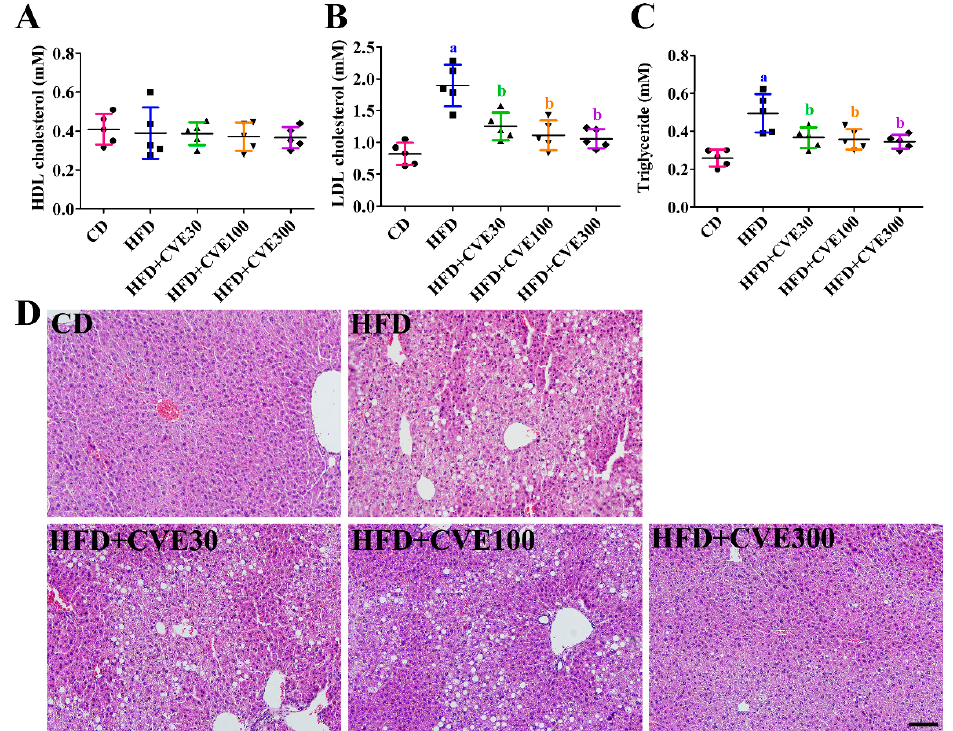
Figure 2. Lipid profiles such as high-density lipoprotein (HDL) cholesterol ( A ), low-density lipoprotein (LDL) cholesterol ( B ), and triglyceride ( C ), as well as the morphology of liver with hematoxylin & eosin staining ( D ) at 8 weeks after treatment in the CD, HFD, HFD+CVE30, HFD+CVE100, and HFD+CVE300 groups. The data were analyzed by one-way analysis of variance followed by Bonferroni’s post hoc test ( a p < 0.05, significantly different from the CD group; b p < 0.05, significantly different from the HFD group). The bars indicate the mean ± standard deviation. CD, control diet; CVE, Cissus verticillata leaf extract; HFD, high-fat diet.